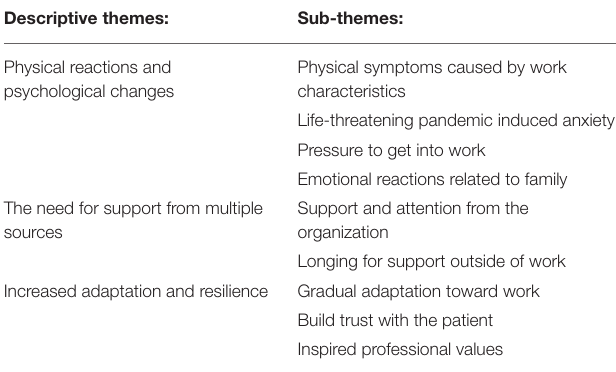
TABLE 3 | Thematic synthesis